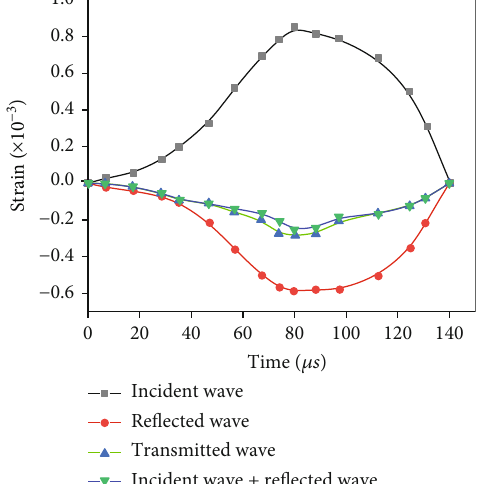
Figure 4: Dynamic typical waveform and veri fi cation of stress balance.